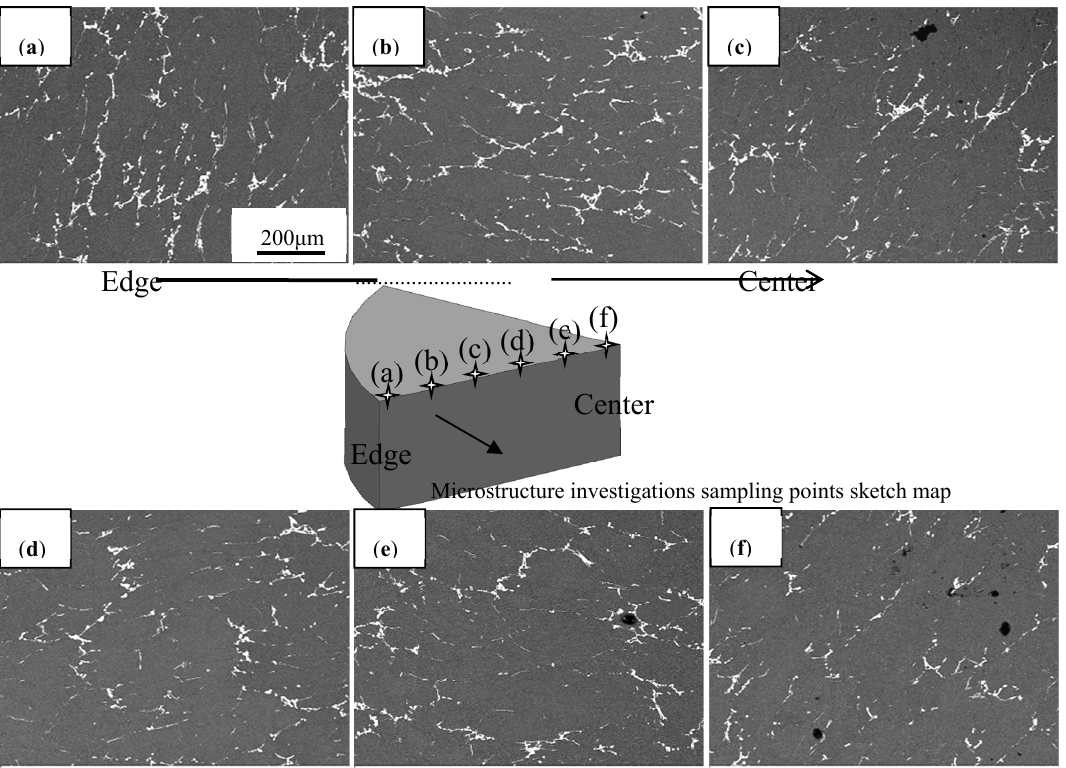
Figure 2. Metallographs of the as-cast 2219 alloy ingot at different distances (mm) along radial direction. ( a – f ) metallographic investigations located 10 mm ( a ); 70 mm ( b ); 130 mm ( c ); 190 mm ( d ); 250 mm ( e ) and 310 mm ( f ) from the ingot edge along the radial direction.